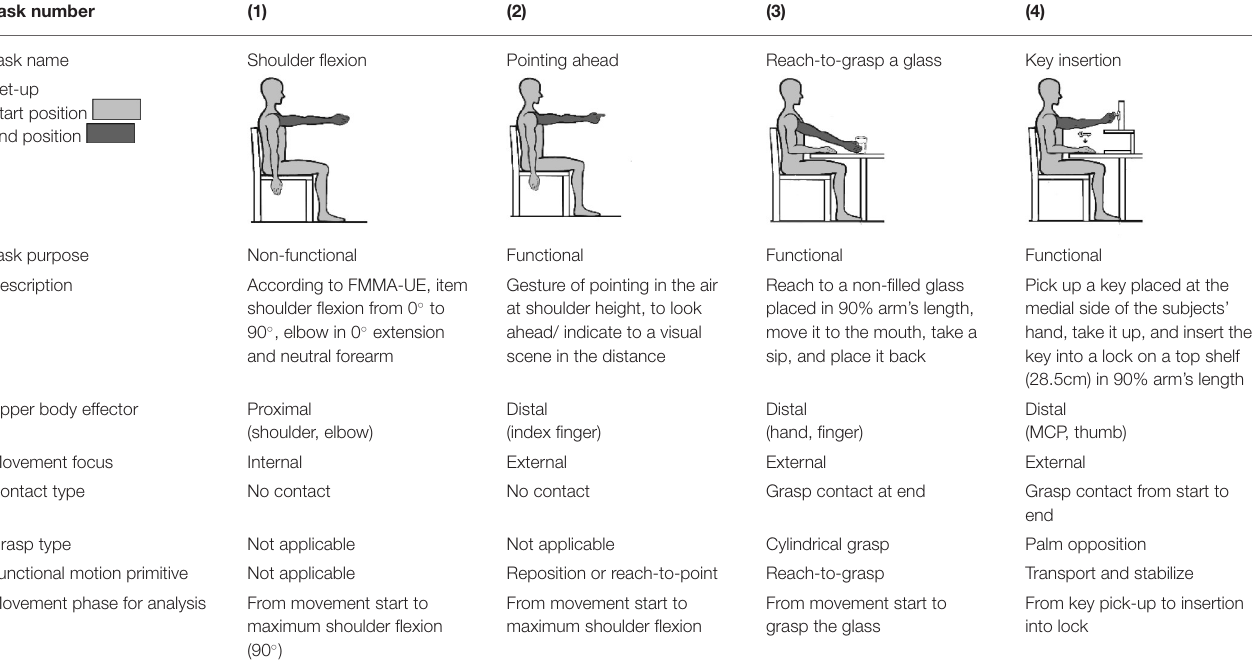
TABLE 1 | Upper limb movement task